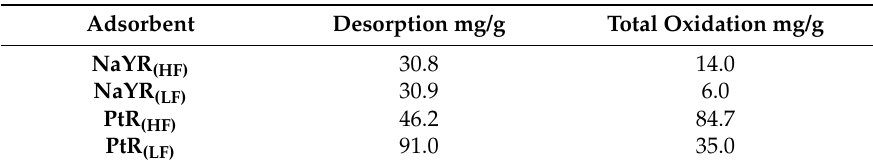
Table 2. Ethanol desorption and total oxidation capacities obtained from ethanol desorption and CO 2 formation profiles in air regeneration.